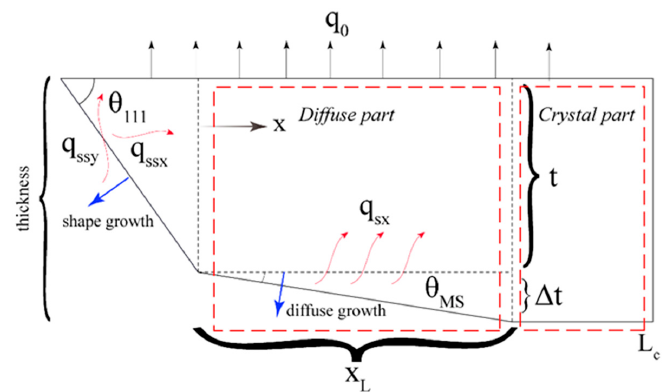
Figure 3. Mathematical model of solid part.